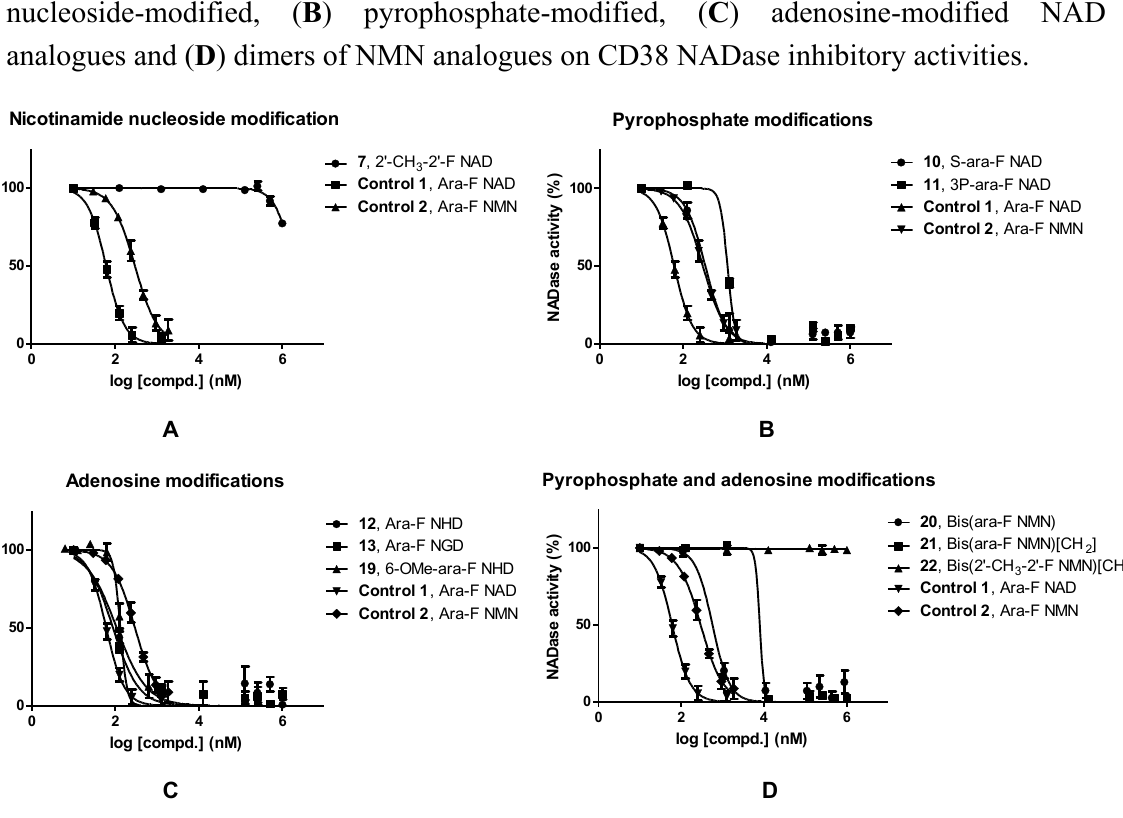
Figure 2. Concentration dependence of inhibitors. Effect of ( A ) nicotinamide nucleoside-modified, ( B ) pyrophosphate-modified, ( C ) adenosine-modified NAD